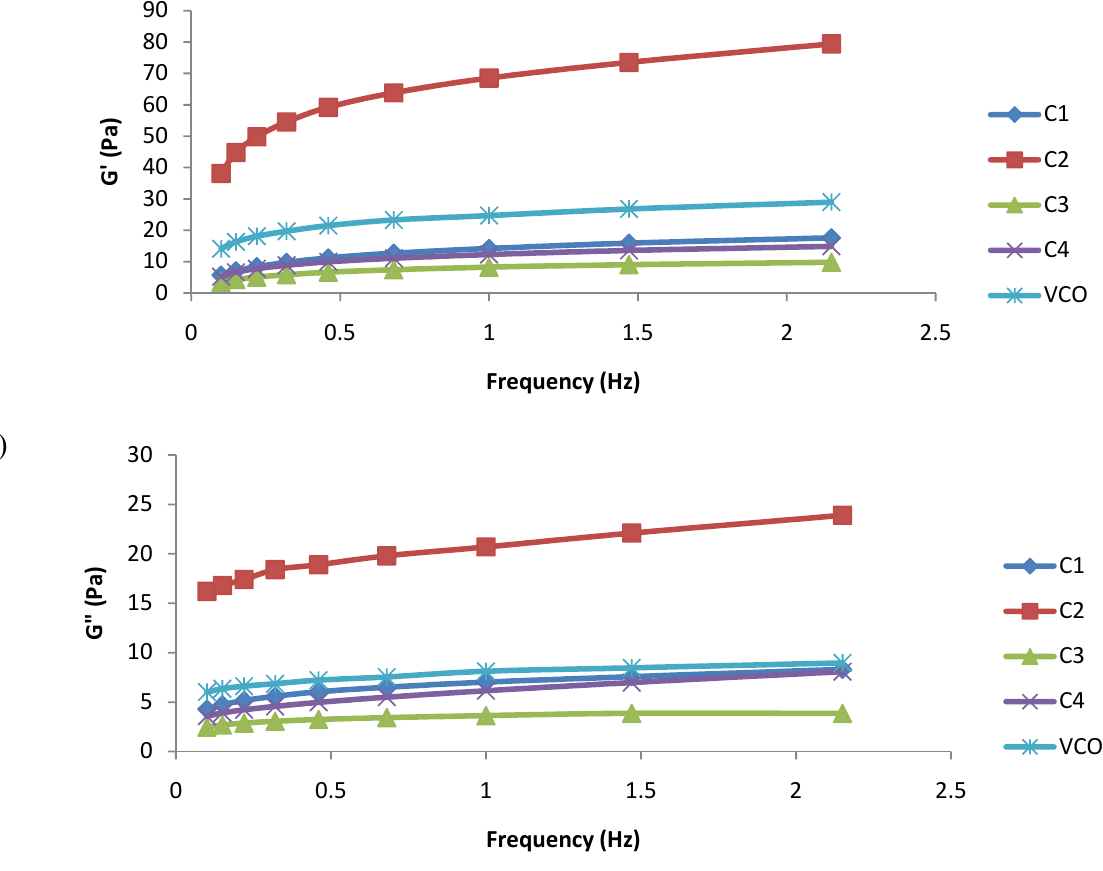
Figure 5. ( a ) Storage modulus G' (Pa) vs. frequency sweep (Hz), ( b ) loss modulus G'' (Pa) vs. frequency sweep (Hz), ( c ) viscosity η (Pa.s) vs. frequency sweep (Hz), and ( d ) loss tangent (tan δ ) vs. frequency sweep (Hz) data for commercial emulsion samples (C1, C2, C3, C4) and virgin coconut oil